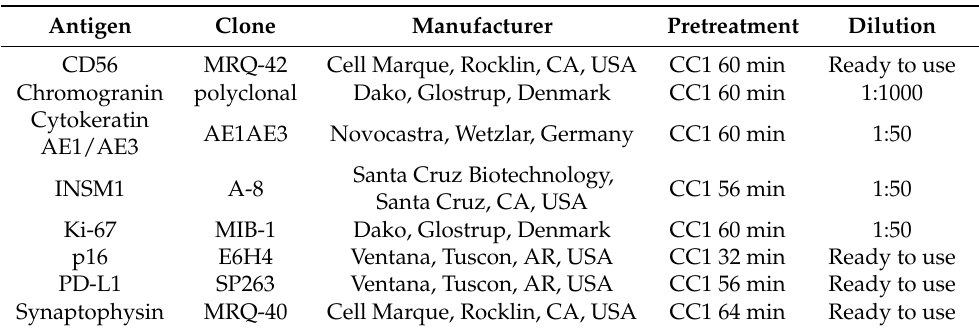
Table 1. Overview of source and clone, dilution of the primary antibodies, and antigen retrieval methods used for immunohistochemistry.